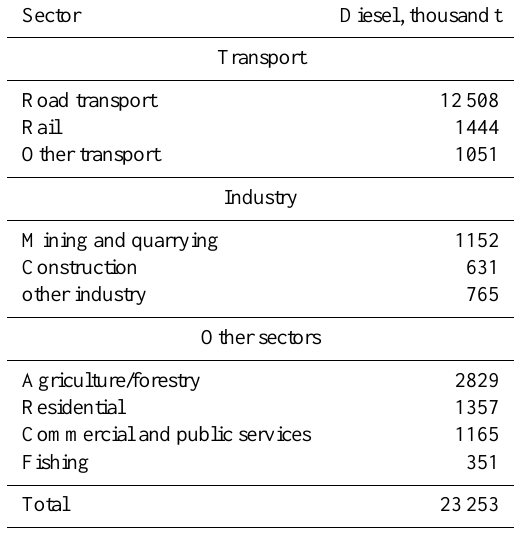
Table 6. Diesel consumption in Russia,